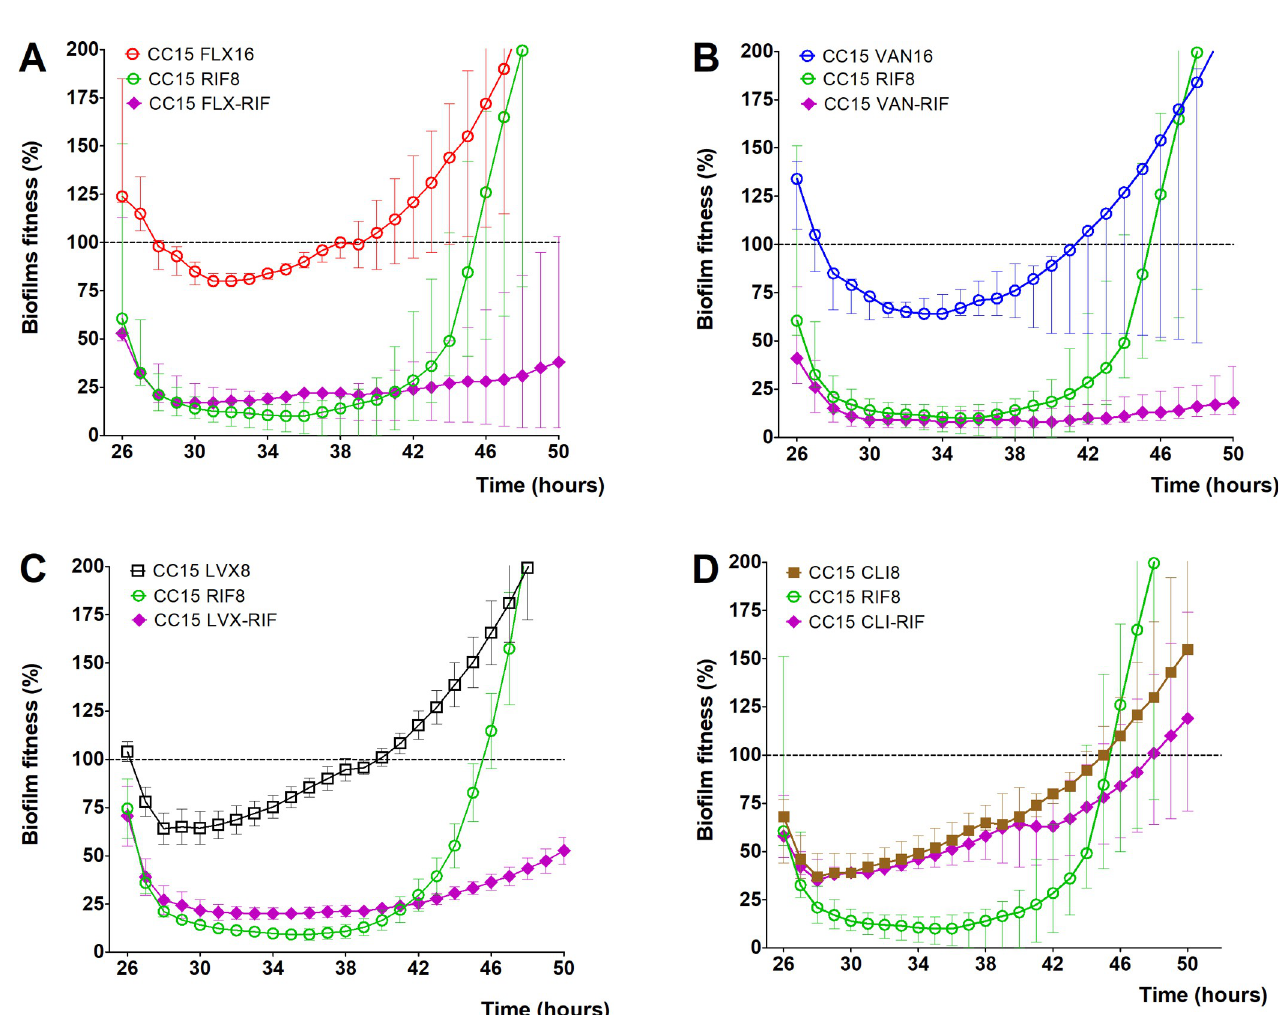
Fig 7. Biofilm-associated S . aureus sensitivity to combination antibiotics. The 24 hours kinetic of biofilm fitness of MSSA CC15 strain towards maximum serum concentration of flucloxacillin (FLX) (A), vancomycin (VAN) (B), levofloxacin (LVX) (C), and clindamycin (CLI) (D) in combination with 8 μ g/mL rifampicin (RIF) was administered to 24 hour-old biofilms grown relative to untreated biofilm fitness. Dashed horizontal lines indicate control (untreated biofilm). Error bars represent median with range (n = 3).